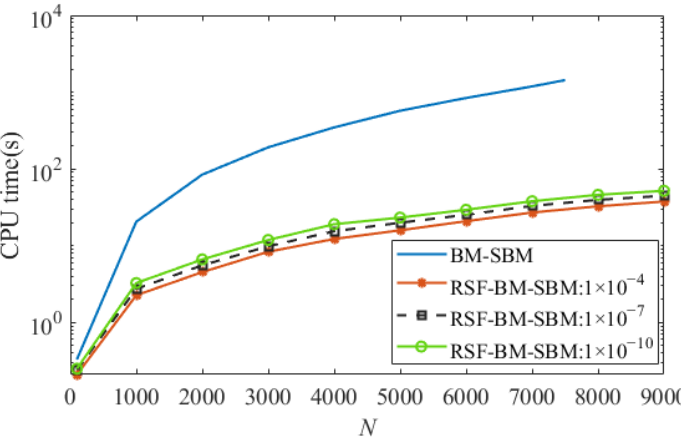
Figure 3. Comparison of CPU computation times under different numbers of nodes.